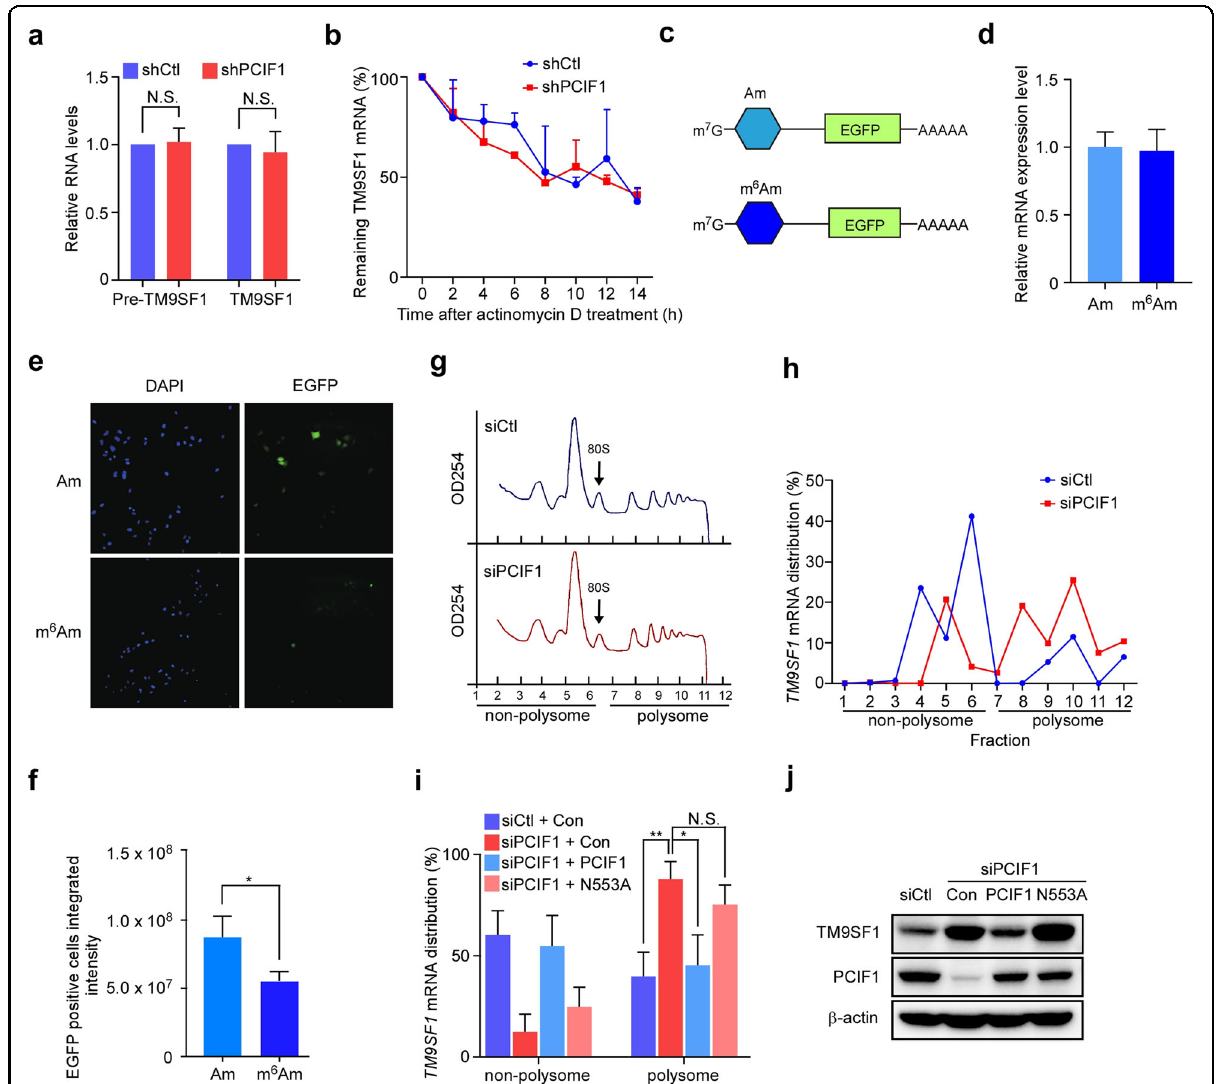
Fig. 4 m 6 Am modi fi cation suppresses TM9SF1 mRNA translation. a Quantitative RT-PCR analysis of precursor or mature TM9SF1 mRNA expression in AGS cells with control or PCIF1 depletion. Data are presented as log 2 value of PCIF1 relative to GAPDH . b Analysis of remaining TM9SF1 mRNA at the indicated times in control and PCIF1-depleted AGS cells after actinomycin D treatment. c – f The expression of m 7 G-Am or m 7 G-m 6 Am EGFP mRNA in Hela cells. EGFP mRNA that starts with either m 7 G-Am or m 7 G-m 6 Am modi fi cation was generated by in vitro transcription ( c ). Cells were transfected with m 7 G-Am or m 7 G-m 6 Am EGFP mRNA and subjected to qRT-PCR ( d ) and fl uorescence microscopy ( e ). Representative images of EGFP in cells are shown. Fluorescence intensity of EGFP-positive Hela cells was quanti fi ed ( f ). DNA was visualized by DAPI. g , h Polysome pro fi ling analysis of TM9SF1 mRNA. The distribution of TM9SF1 mRNA in each fraction of control and PCIF1-depleted BGC-823 cells was determined by qRT- PCR. i Analysis of TM9SF1 mRNA distribution in the fractions of non-polysome and polysome from BGC-823 cells with the indicated siRNA and plasmids. j Western blot analysis of TM9SF1 in AGS cells with the indicated shRNA and plasmids. Data are shown as means ± SD. N.S. not signi fi cant; * P < 0.05, ** P < 0.01, Student ’ s t